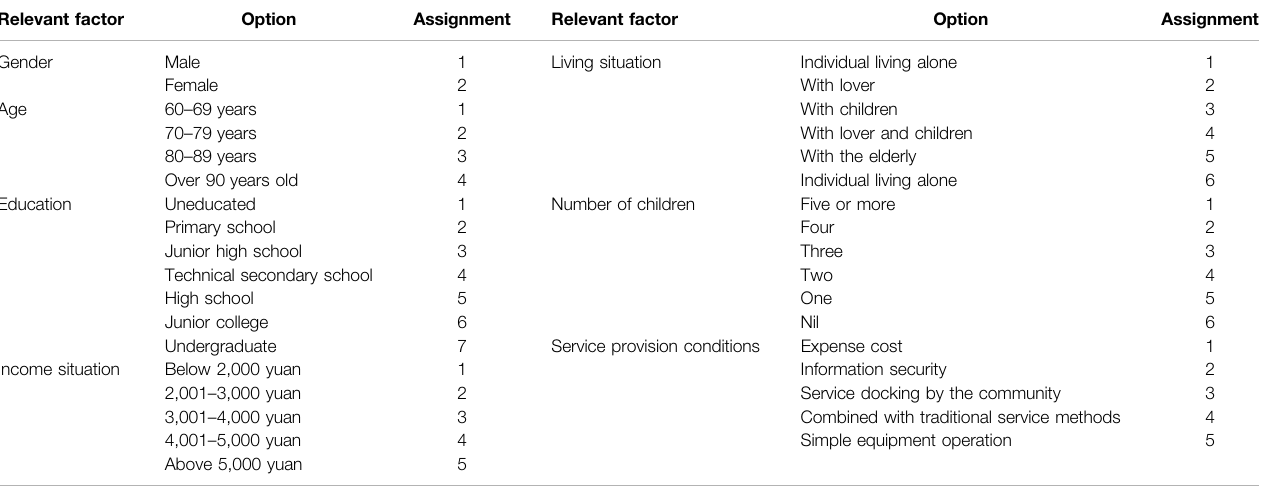
TABLE 8 | Assignment of related